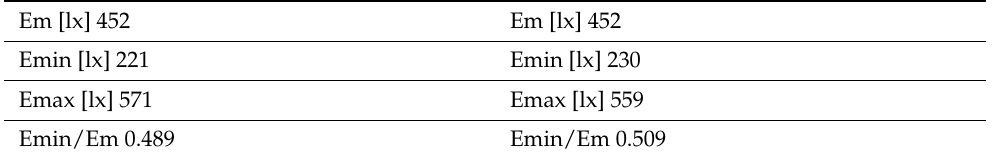
Figure 27. Surface lighting vs. linear by Lorenzo Muro. Table 3. Surface lighting vs. linear lighting. Calculations with Lightscape 3.2. by Lorenzo Muro.